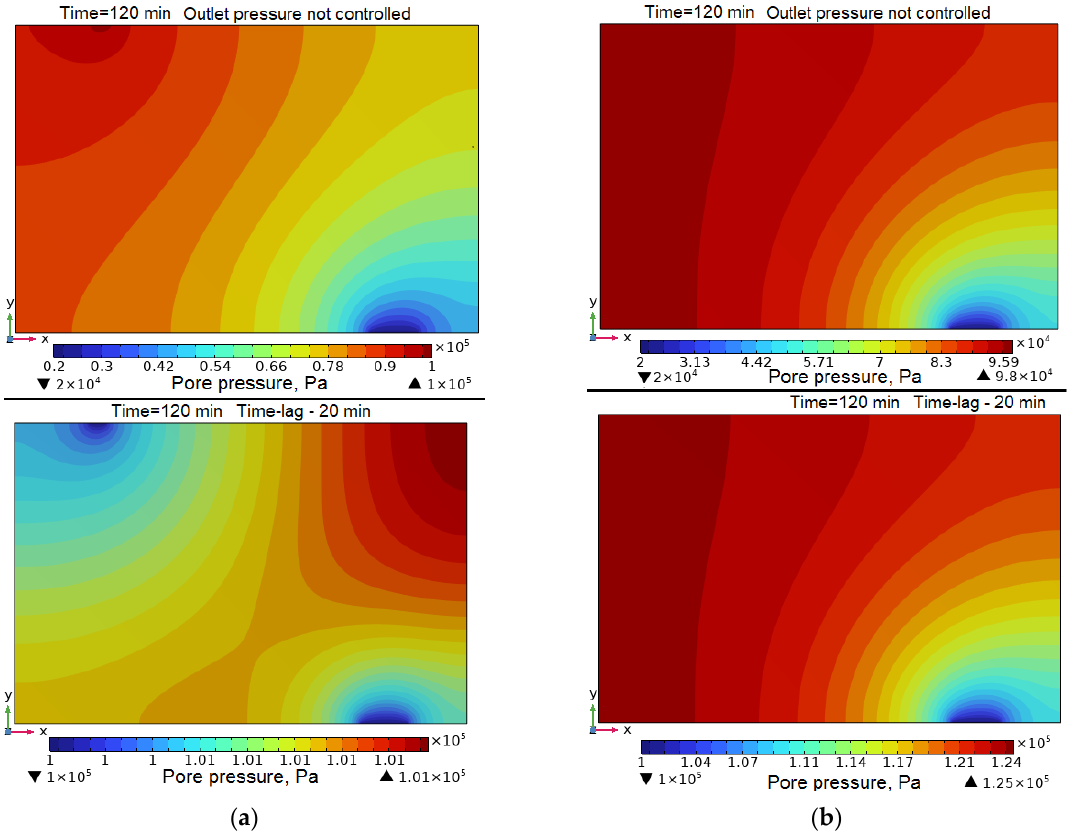
Figure 8. Distribution of pore pressure in preforms after 2 h of exposure to compressive pressure p appl according to the 1st ( a ) and 2nd ( b ) scenarios. The upper pictures correspond to the case of a constant pressure at the outlet p out = p vac = 20 kPa, whereas the lower pictures correspond to the outlet pressure that began to grow 20 min after the start of the process and reached atmospheric p out = p atm = 100 kPa.